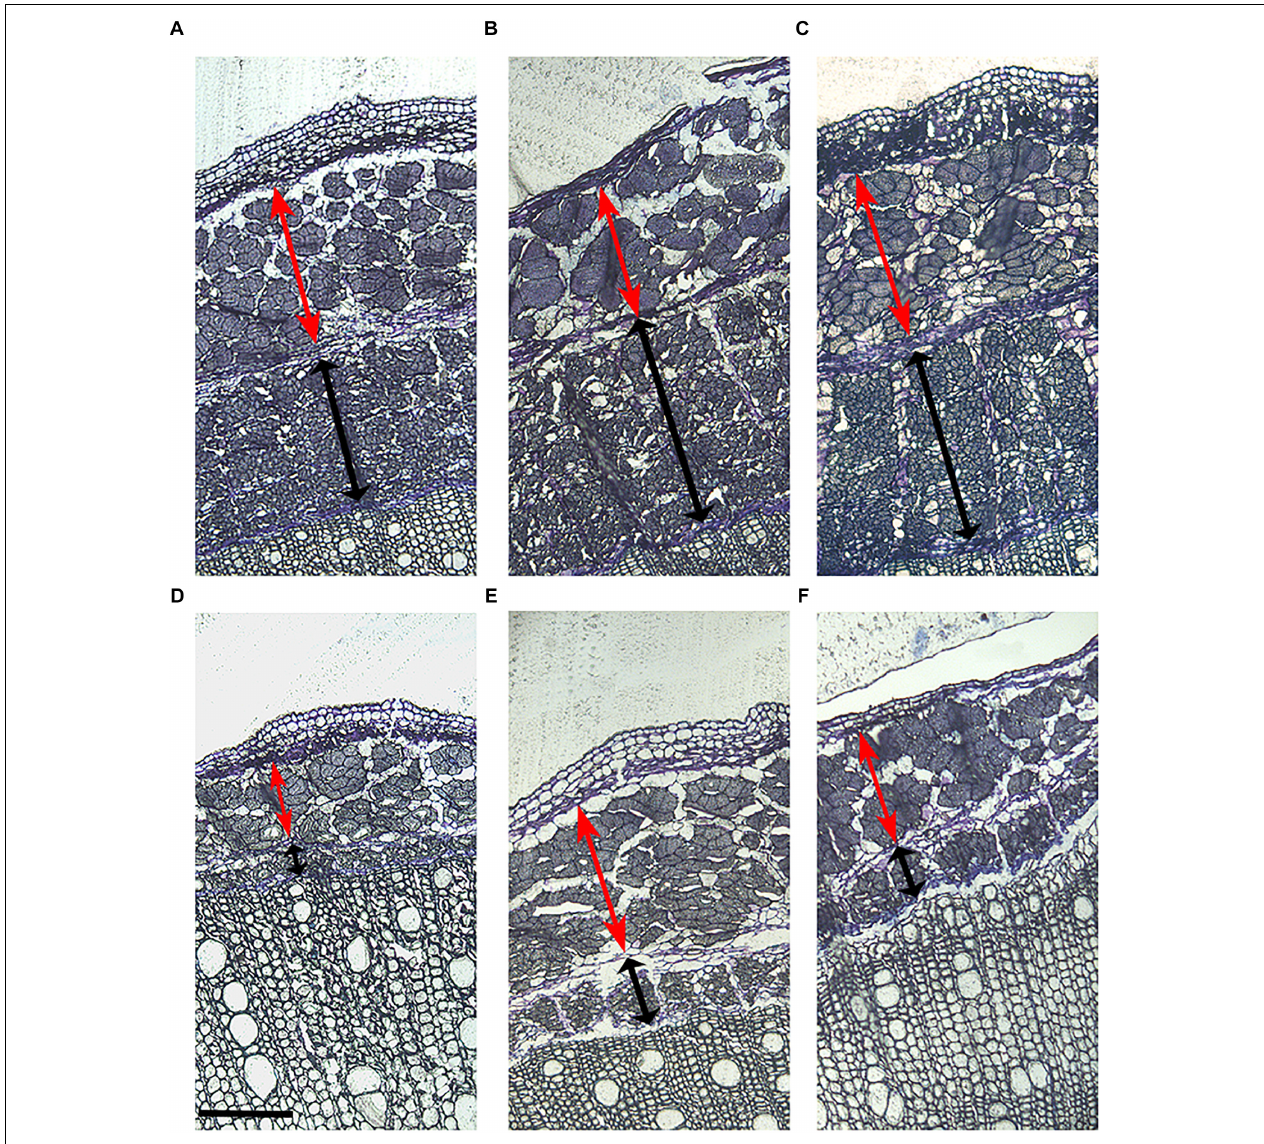
FIGURE 6 | Primary and secondary bast fiber of six contrasting hemp accessions. (A) CRA412, (B) FNPC243, (C) WU101, (D) CRA410, (E) CRA416, and (F) CRA420. Red arrows indicate the primary bast fiber, black arrows indicate the secondary bast fiber and scale bars are equivalent to 200 µ